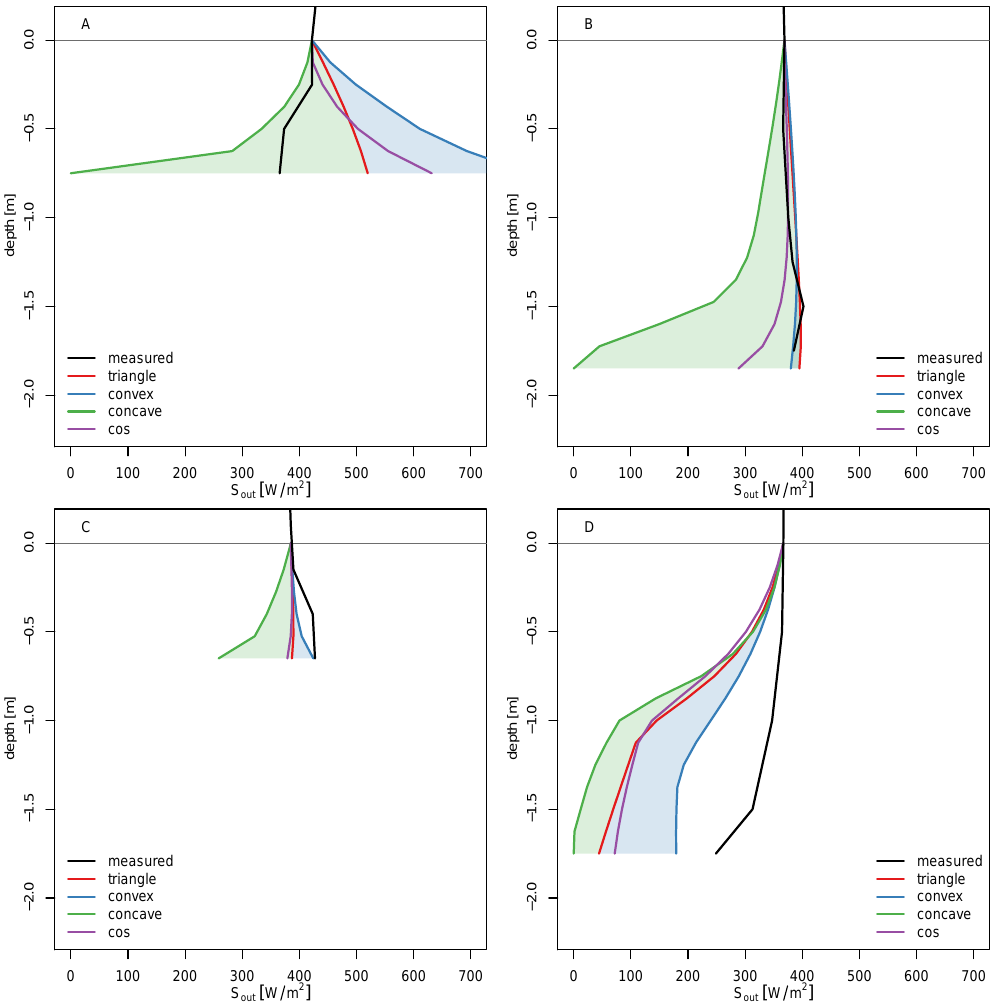
Figure 6. Measured and modeled outgoing radiation by the sensor placed at different depths within the penitente trough. The measured outgoing radiation has been normalized to have uniform incoming radiation. The solid lines represent the S out for the uniform material albedo whereas the blue/green shaded area is the variability in S out due to the uniform distributions U( min , max ) in Table